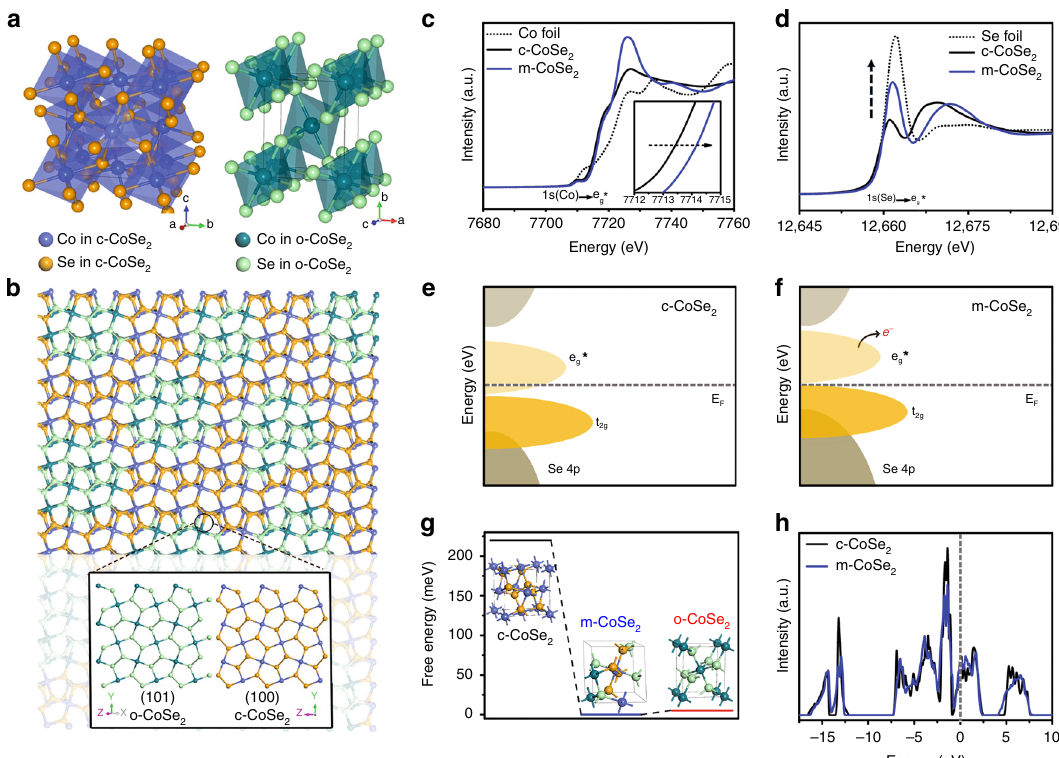
Fig. 5 DFT calculation and stability mechanism. a Crystal structures of the c-CoSe 2 (left) and o-CoSe 2 (right). b Schematic structure model of m-CoSe 2 showing the [c-CoSe 2 (100)||o-CoSe 2 (101)] interface. Insets are the atomic models of the o-CoSe 2 (101) and c-CoSe 2 (100) surfaces, respectively. c , d XANES spectra recorded at the Co K-edge ( c ) and Se K-edge ( d ) of the Co foil, Se foil, c-CoSe 2 , and m-CoSe 2 , respectively. Inset in c shows the zoomed view of the Co K-edge spectra. e , f Schematic rigid band diagrams of the c-CoSe 2 ( e ) and m-CoSe 2 ( f ). g Calculated free energy of the c-, o-, and m-CoSe 2 unit cells. Insets show corresponding unit cell structures. h DOS of the c-CoSe 2 and m-CoSe 2 with the Fermi level aligned at 0